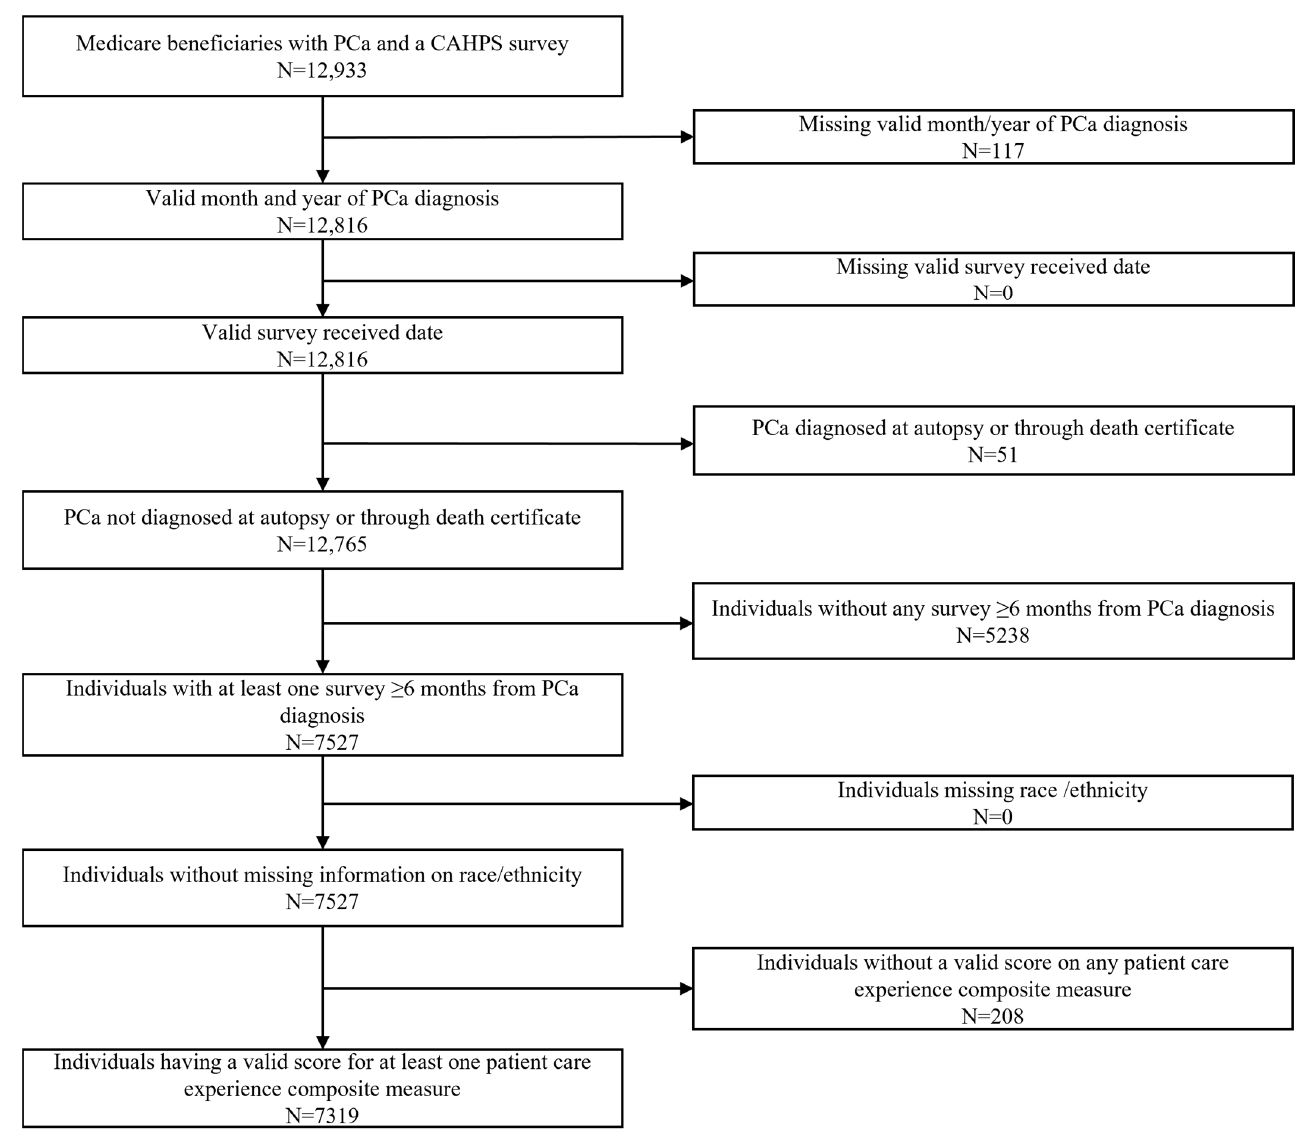
Figure 1. Sample selection flow chart for study sample . PCa: Prostate cancer; CAHPS: Consumer Assessment of Healthcare Providers and Systems.